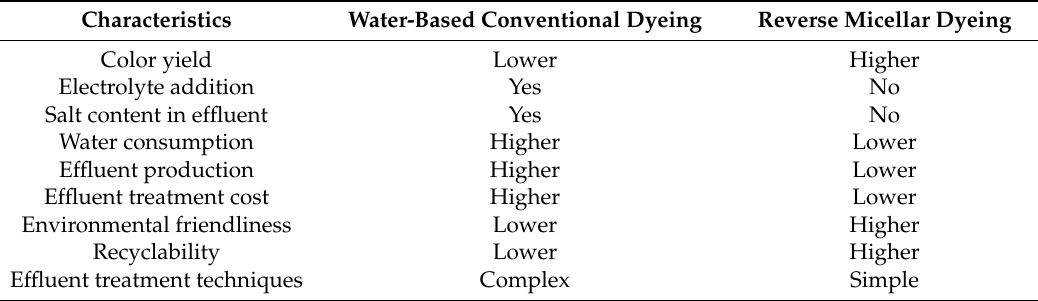
Table 1. Comparison between conventional and reverse micelle